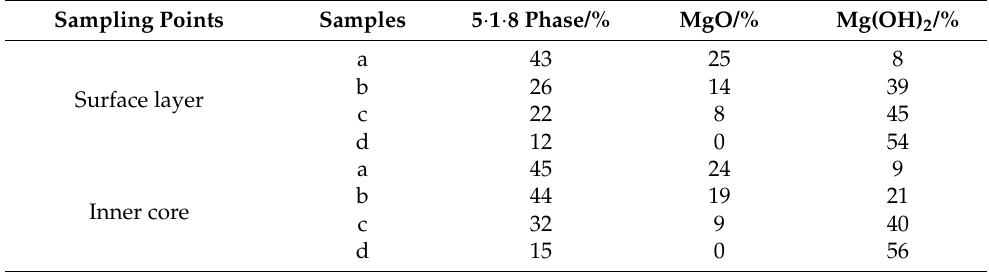
Figure 11. XRD patterns of the inner cores of the MOC samples after different dry–wet cycles: (a) without dry–wet cycles; (b) one time; (c) two times; (d) three times. Table 3. Content of the main phase for the surface layers and inner cores of the MOC samples after different dry–wet cycles: (a) without dry–wet cycles; (b) one time; (c) two times; (d) three times. Sampling Points Samples